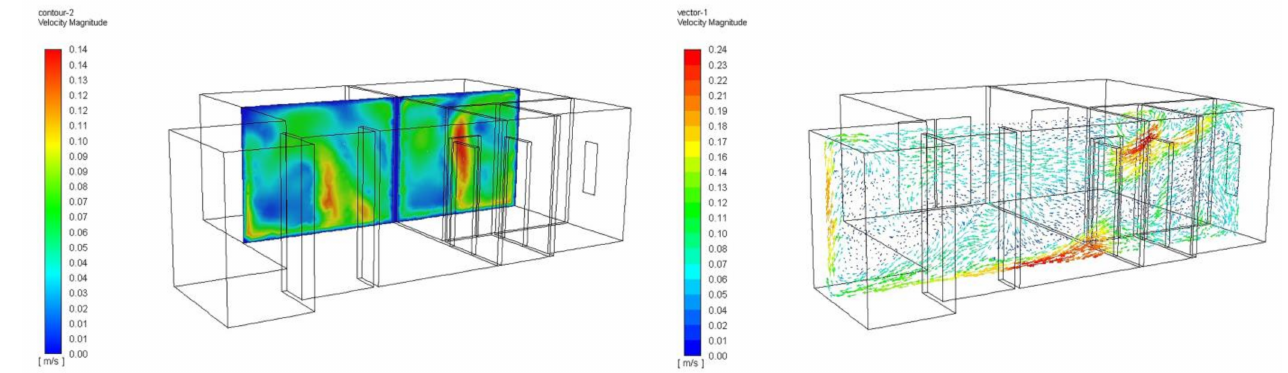
Figure 11. Temperature gradient and air velocity vectors in different rooms.